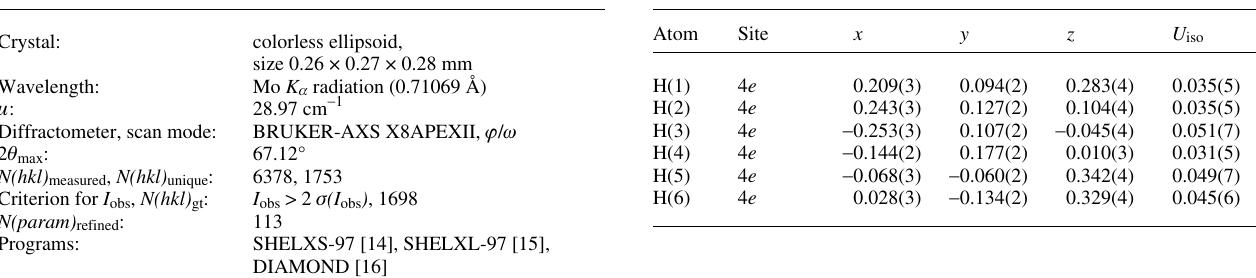
Table 4. Data collection and handling. Table 5. Atomic coordinates and displacement parameters (in Å 2 ) .